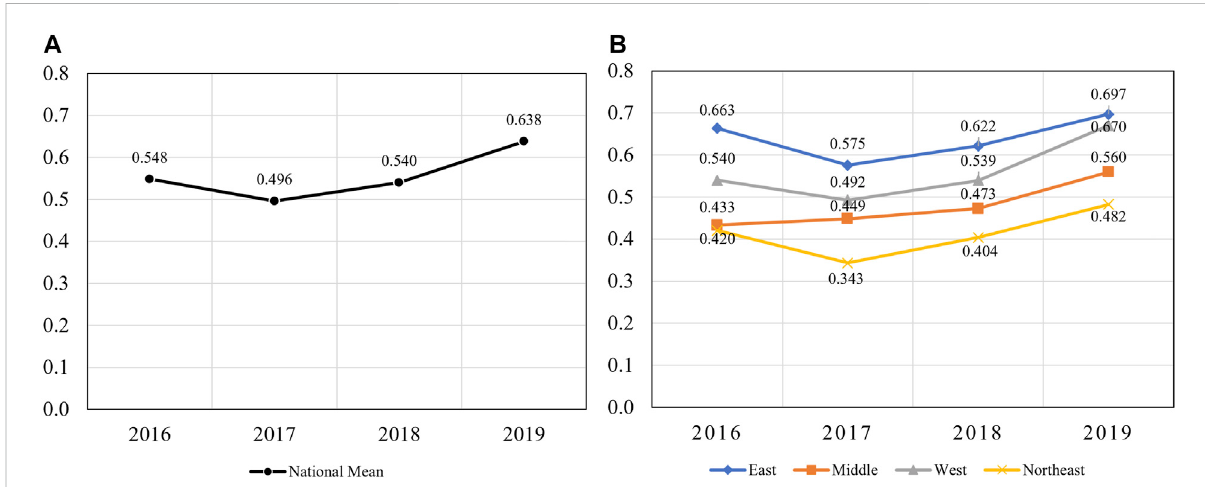
FIGURE 2 TET values of Chinese provinces. Note: (A) the average of national TET, (B) east, central, west and northeast China, the division is based on (https://